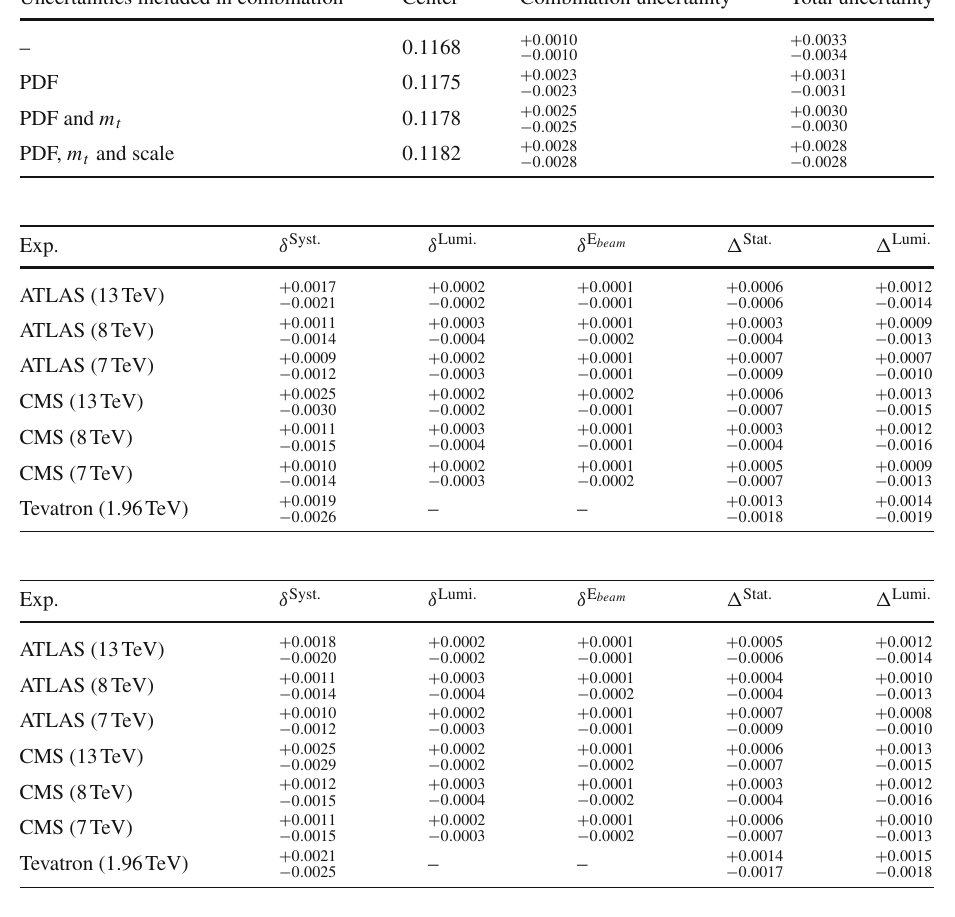
Uncertainties included in combination Center